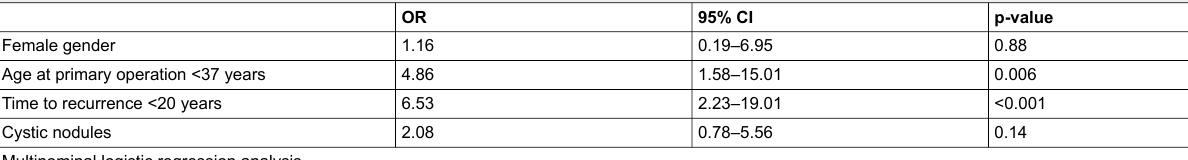
Table 3: Multivariate analysis for risk factors for contralateral